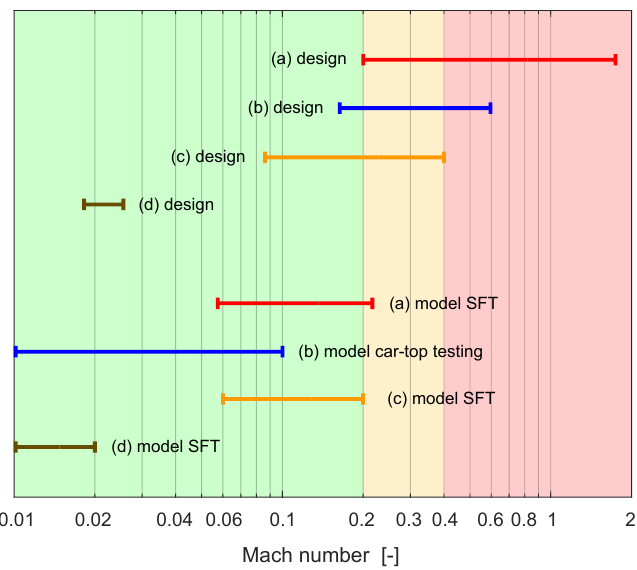
Figure 3. Mach number at which the subscale models of Table 4 are tested in the open atmosphere, compared to the Mach number range where the full-scale vehicles would be operated. The back- ground colours represent incompressible (green), risk of compressibility (yellow) and compressible (red) flow